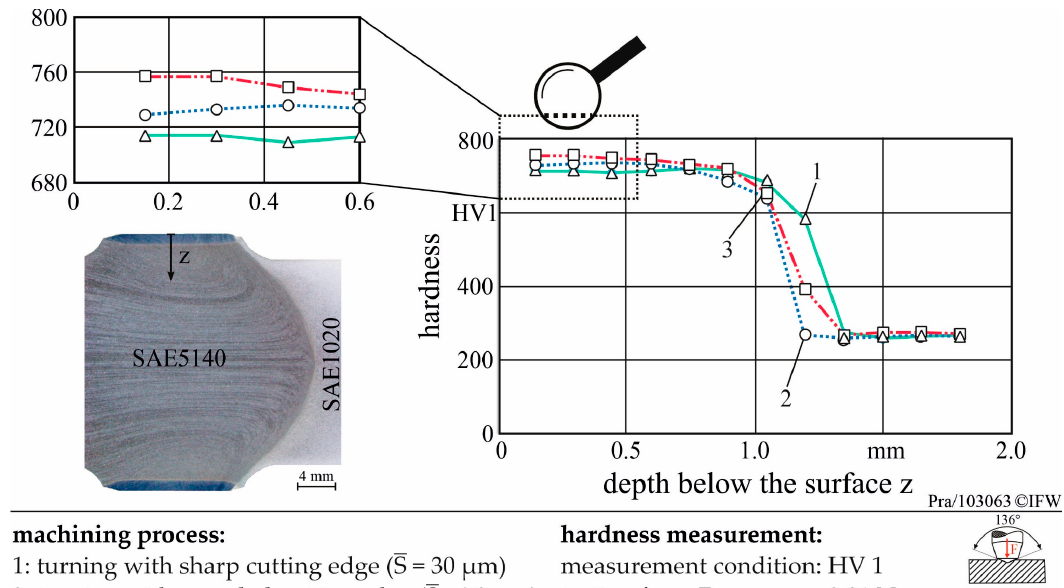
Figure 6. Influence of different manufacturing processes on surface hardness.